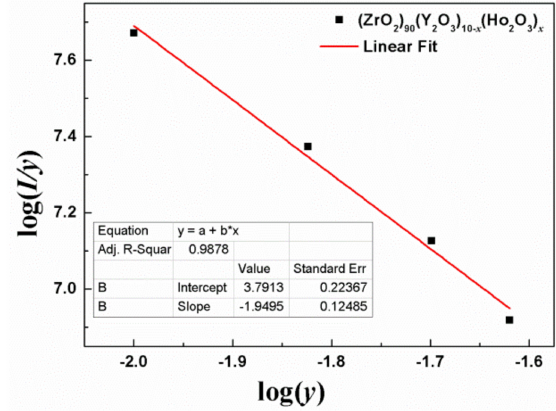
Figure 12. Relationship between log( I/y ) vs. log( y ) in (ZrO 2 ) 90 (Y 2 O 3 ) 10 − x (Ho 2 O 3 ) x crystals.